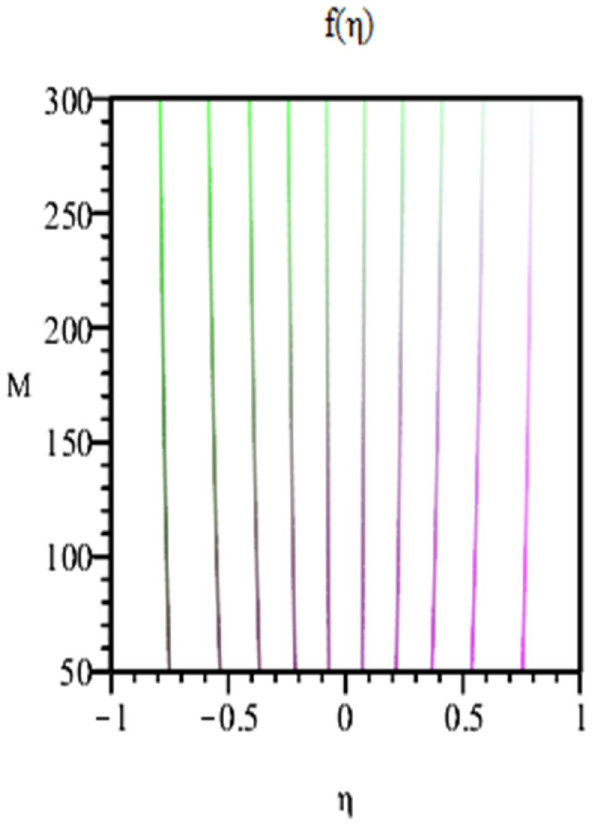
Figure 10. Contour of Axial velocity for ϕ 1 = ϕ 2 = 0.01, Sc = 1, α = 3, Re = − 1, Pr = 6.2